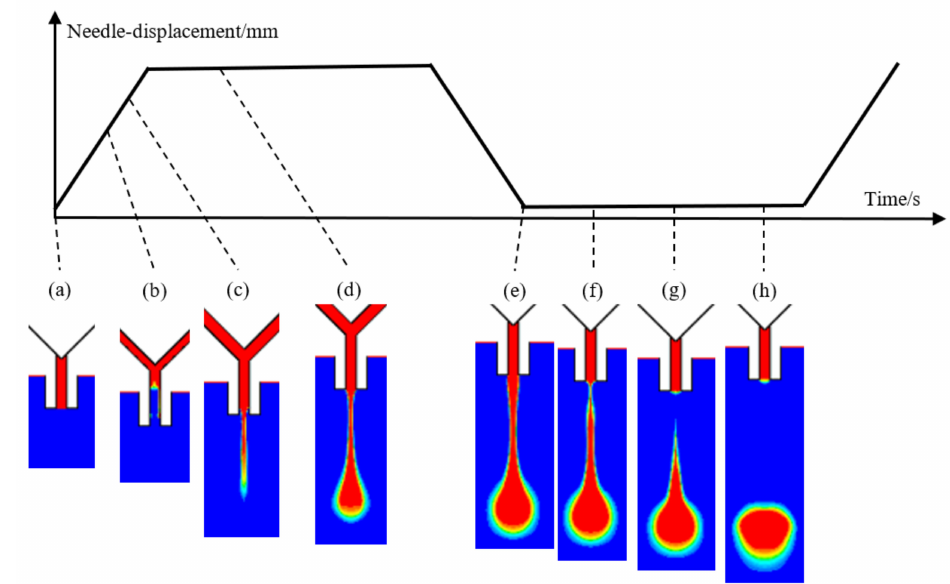
Figure 3. The droplet morphologies in a jetting cycle under the needle vibration: ( a ) start; ( b ) backflow;